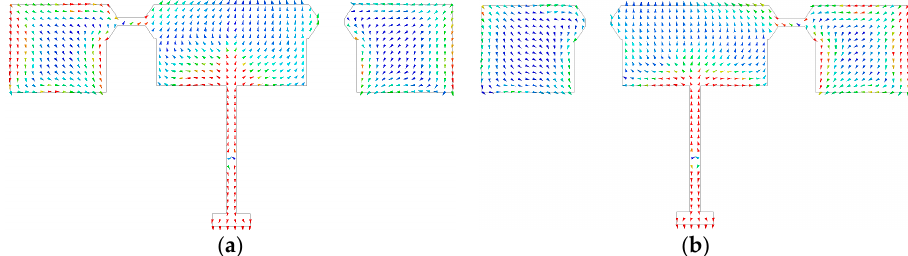
upper and lower slots of main and assistant radiating patches (shown in Figure 5), when the left switch is in the up state and right is in the down state. The same conclusion can be applied to other modes where the switches were in the different states.